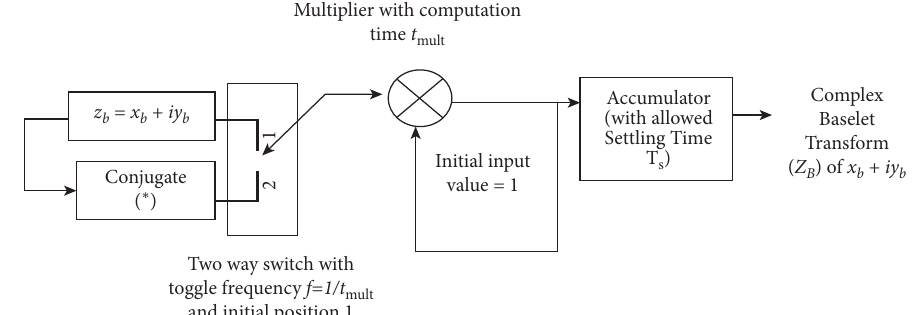
Figure 1: Implementation unit of Z